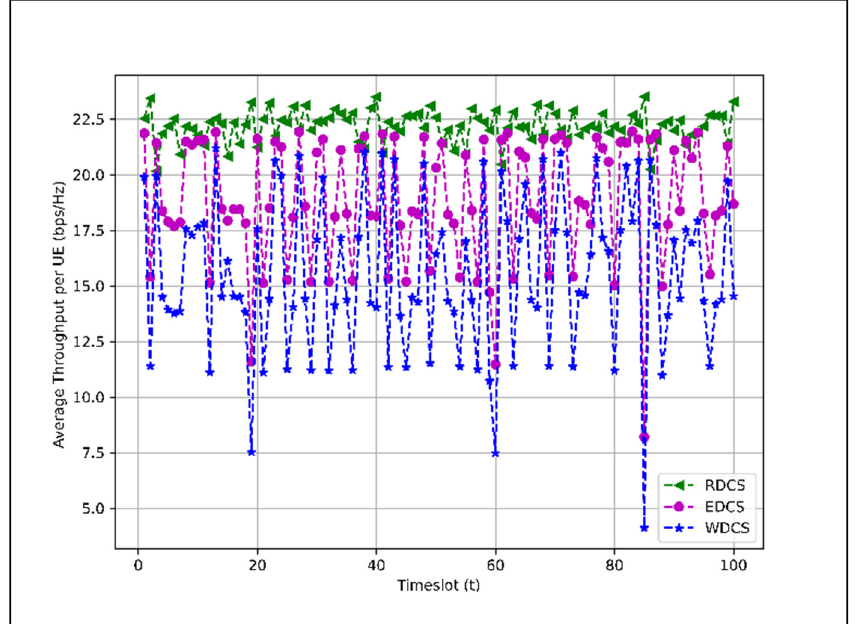
Figure 12. Bandwidth normalized average throughput per user (bps/Hz) for 100